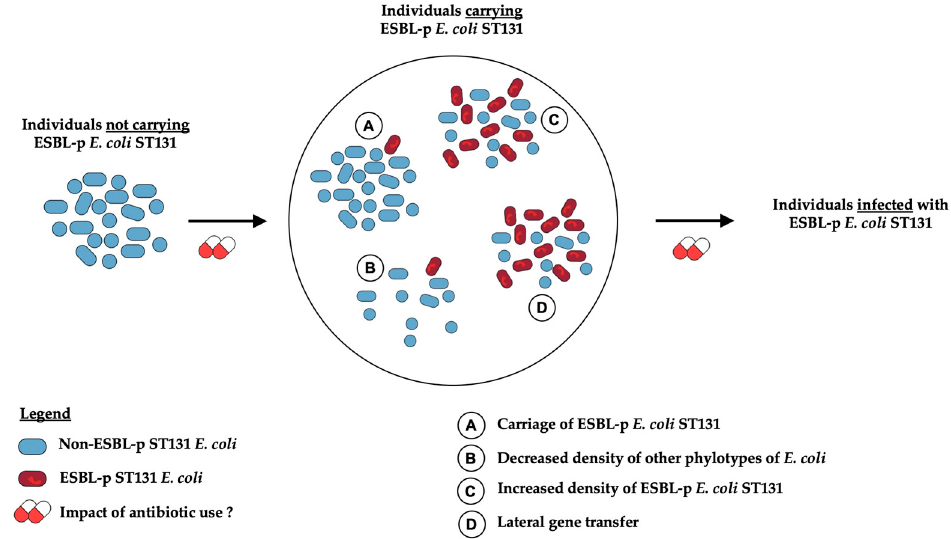
Figure 1. Pathophysiological hypothesis to study antibiotic exposure as a risk factor for infection with ESBL-producing Escherichia coli ST131.